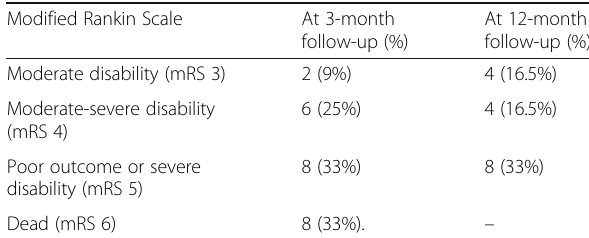
Table 2 Patient outcomes on the modified Rankin